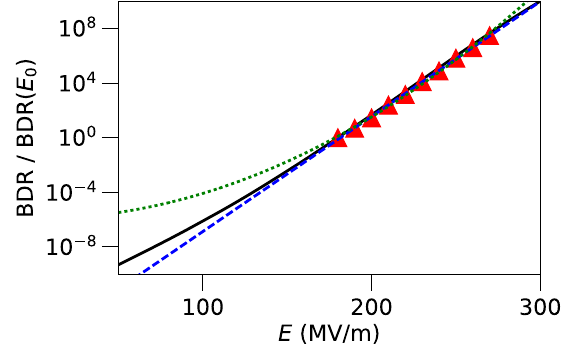
FIG. 7. BDR as a function of the electric field. The solid line is the metastable approximation [Eq. (9) in the main text], the triangles are the simulation results, and the dashed and dotted lines are linear and quadratic fits, respectively, see